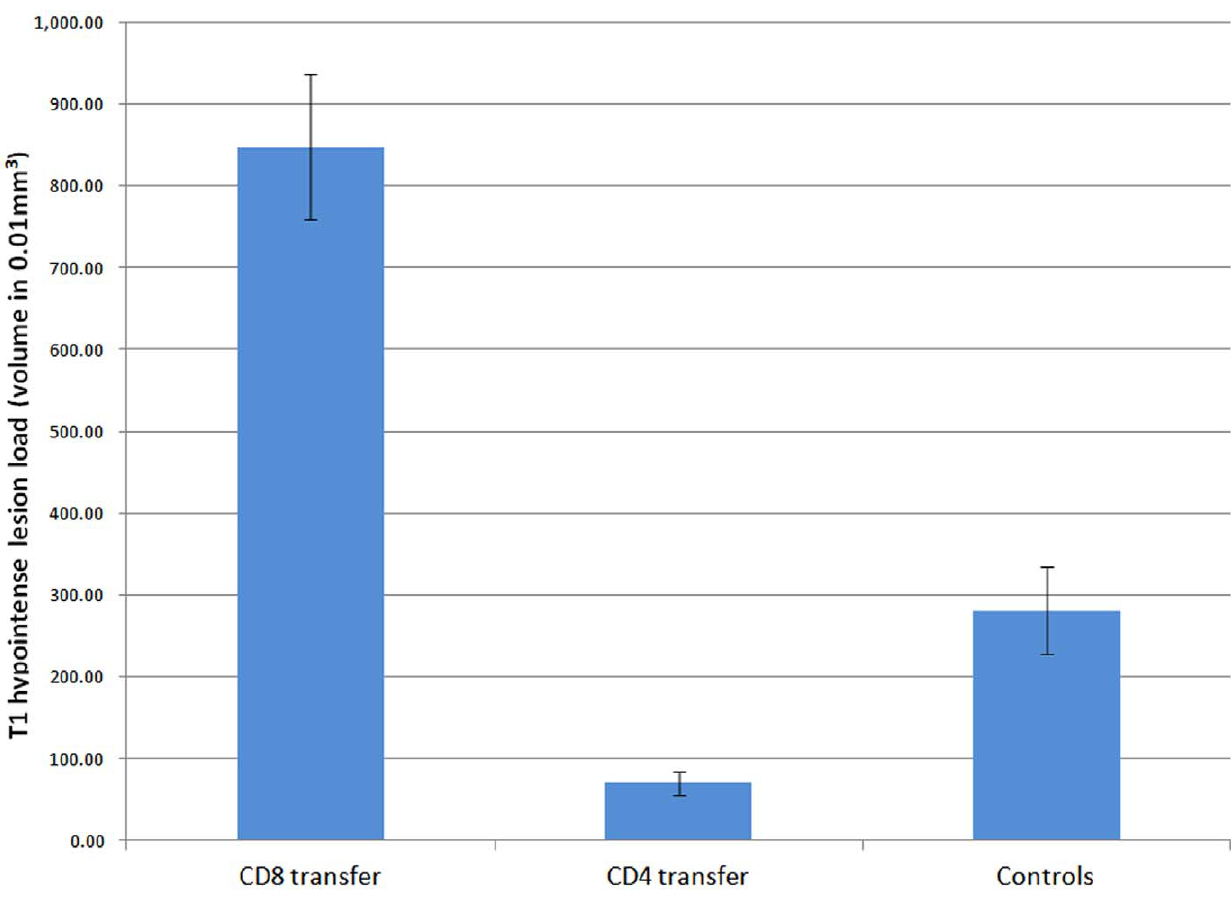
Figure 2. MRI T1BH volumetry results in adoptive transfer experiments using RAG 1 2 / 2 recipient mice. The bar chart shows the mean T1BH volumes in CD8 and CD4 adoptive transfer experiments. Controls represent sham transfer (PBS injection) following irradiation and infection. CD8 T cell transfer resulted in 3-fold increase of T1BH formation, while CD4 transfer resulted in a 2-fold decrease. Error bars represent SD.